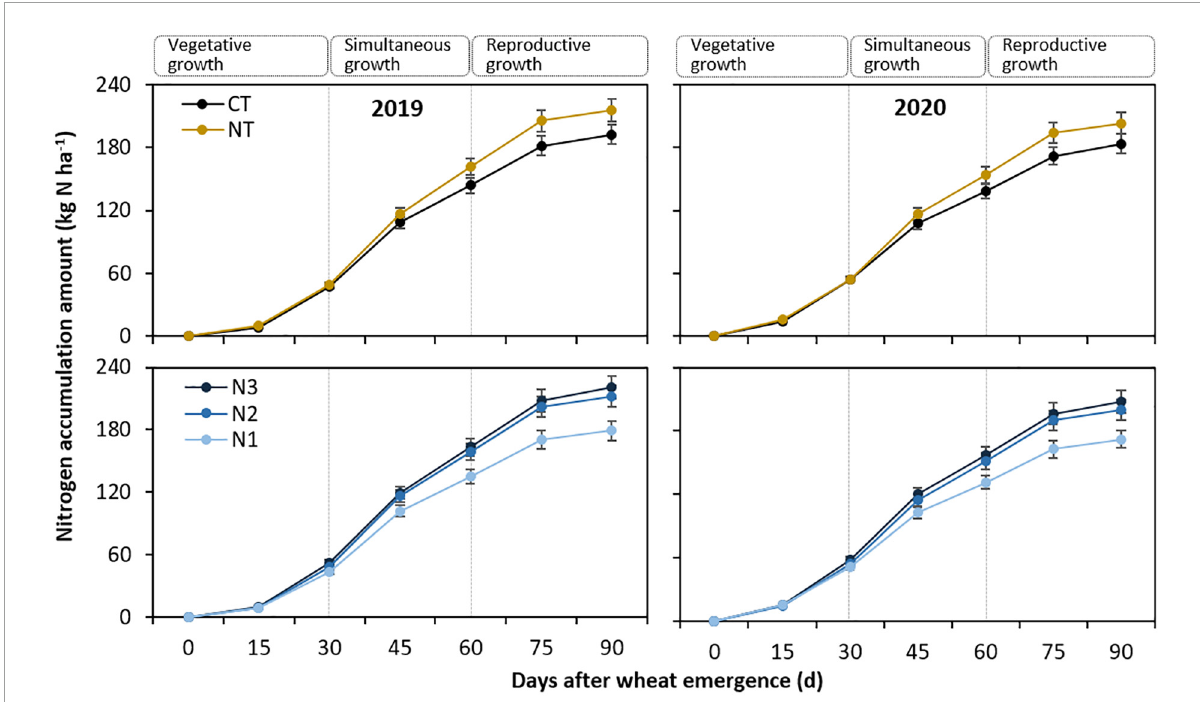
FIGURE2 Nitrogen accumulation amount (NacA) of spring wheat with two tillage practices and three N fertilizer rates in 2019 and 2020. CT and NT represent conventional tillage without plastic film mulching and no-till with previous plastic film mulching. N1, N2, and N3 represent N fertilizer applied at 135, 180, and 225 kg N ha - 1 , respectively. The smaller bars are standard error of means ( n = 3).